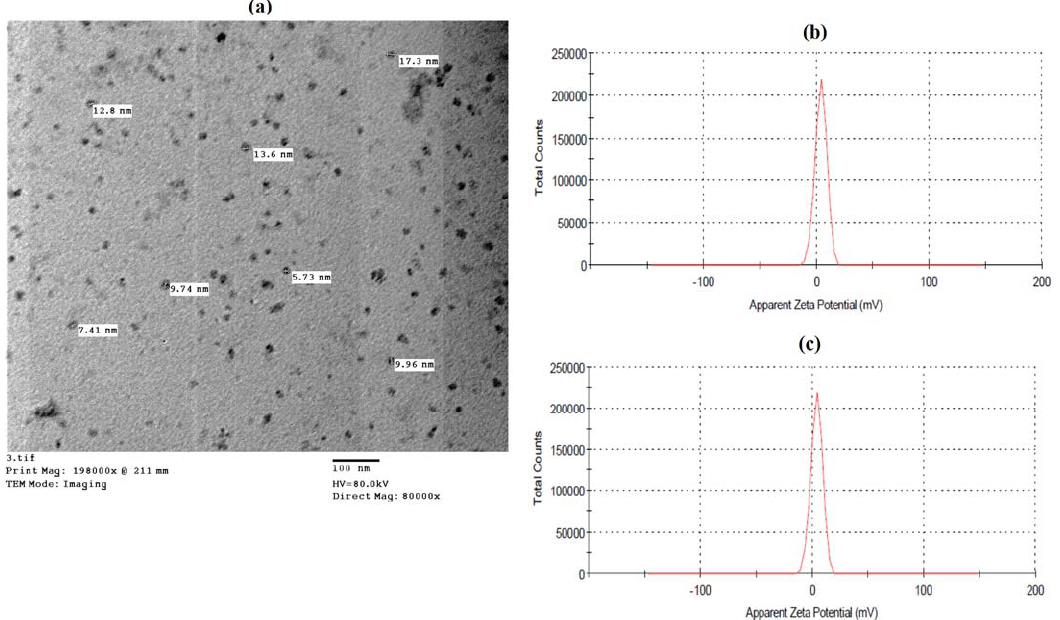
Figure 1. Characterization of salicylic acid nanoparticles using Transmission electron microscopy (TEM), Zeta potential, and Zeta sizer. ( a ) Transmission electron microscopy (TEM) of SA-NPs, ( b ) zeta potential of SA-NPs, and ( c ) average size of SA-NPs.